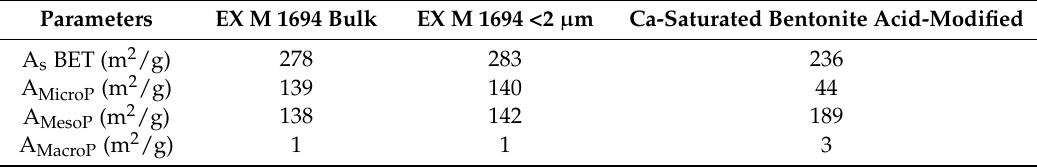
Table 2. Surface and porosity characteristics of the talc-saponite interstratification in comparison to an acid-modified bentonite based on BET (p/p 0 = 0.01–0.2) and DFT